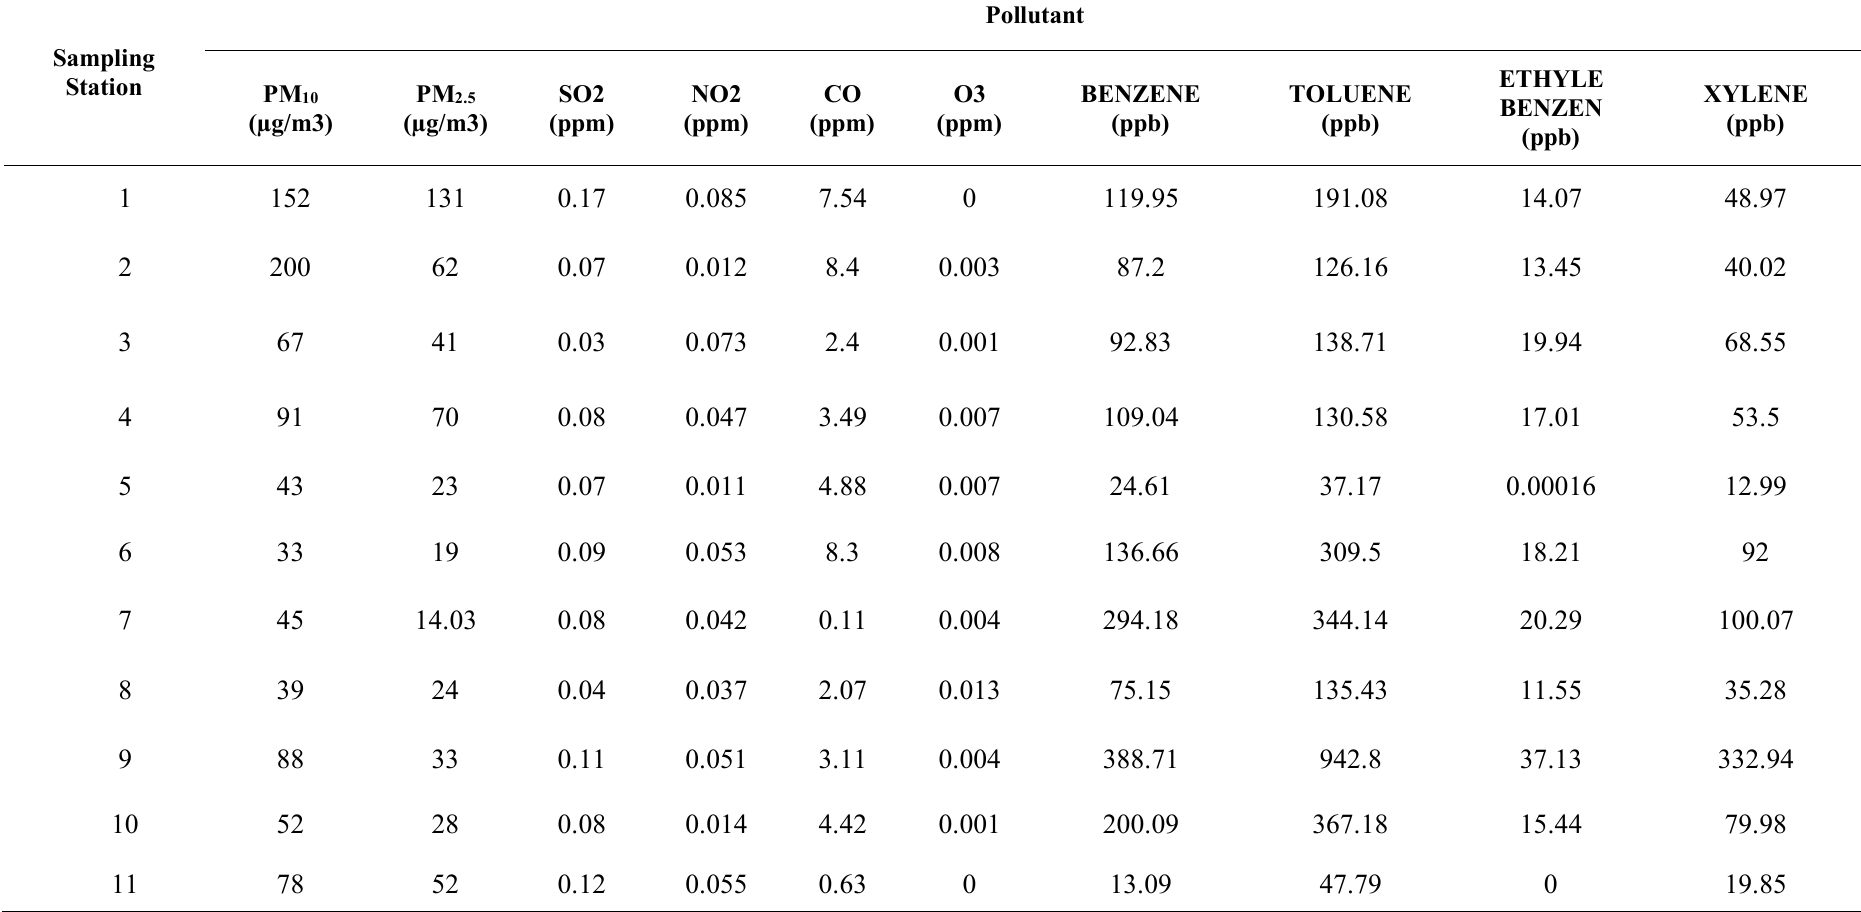
Table 2. The results of analyzing pollutants on January, 2018